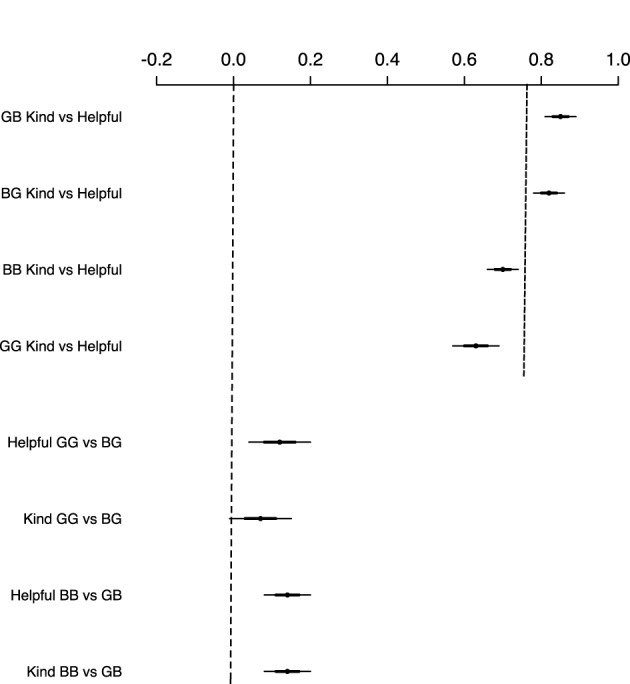
Correlations of same-sex and opposite-sex nominations of helpfulness and kindness, and BCa bootstrapped 90% (darker lines) and 95% (lighter lines) confidence intervals (CIs). Kind: counts of peer nominations for being “often kind and friendly toward others;” helpful: counts of peer nominations for being “ready to lend a helping hand when they see someone in need of that;” GB: girls nominating boys; BG: boys nominating girls; BB: boys nominating boys; GG: girls nominating girls. A vertical line on the top right of the figure at around 0.75 mark does not cross any of the CIs, showing that the same-sex and opposite-sex correlations flanking on the two sides of the line appear to be reliably different from each other.